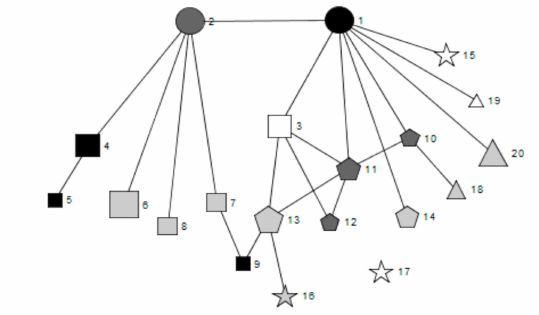
Figure 5. Net-map of wellbeing lead’s ego network for Greenfield